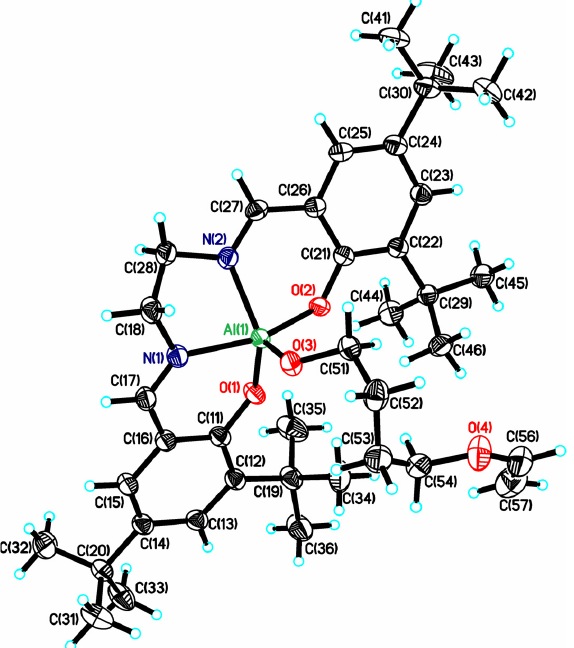
Figure 1. The molecular structure of complex 3c . Displacement ellipsoids are shown at a 50% probability level. The solvated toluene molecule is omitted for clarity. Selected bond lengths (Å) and angles (deg): Al(1)-O(3) 1.7437(13), Al(1)-O(1) 1.7900(12), Al(1)-O(2) 1.8119(12), Al(1)-N(2) 2.0074(15),